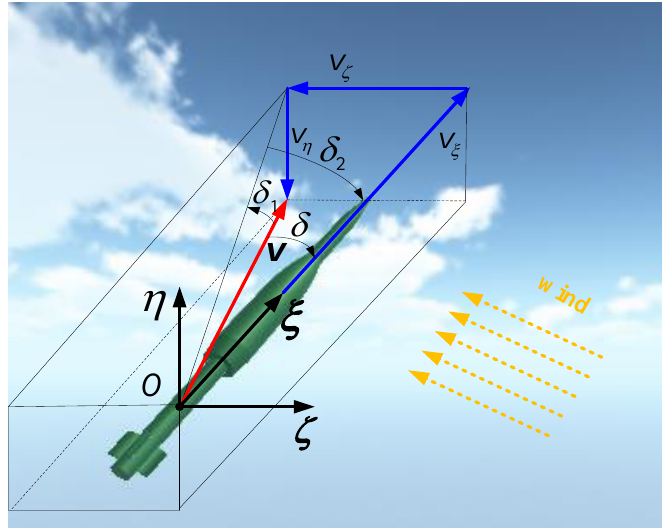
Figure 10. Attack angle diagram of the rocket projectile.